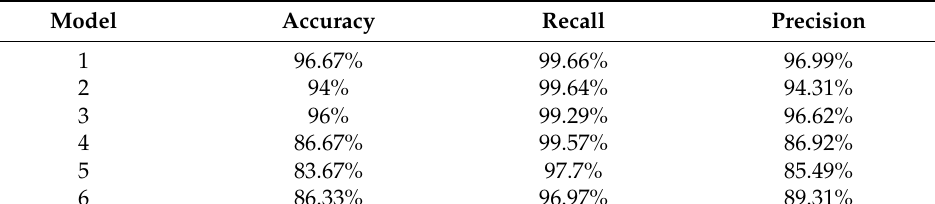
Figure 5. Average classification recall percentages over five subjects with six models.